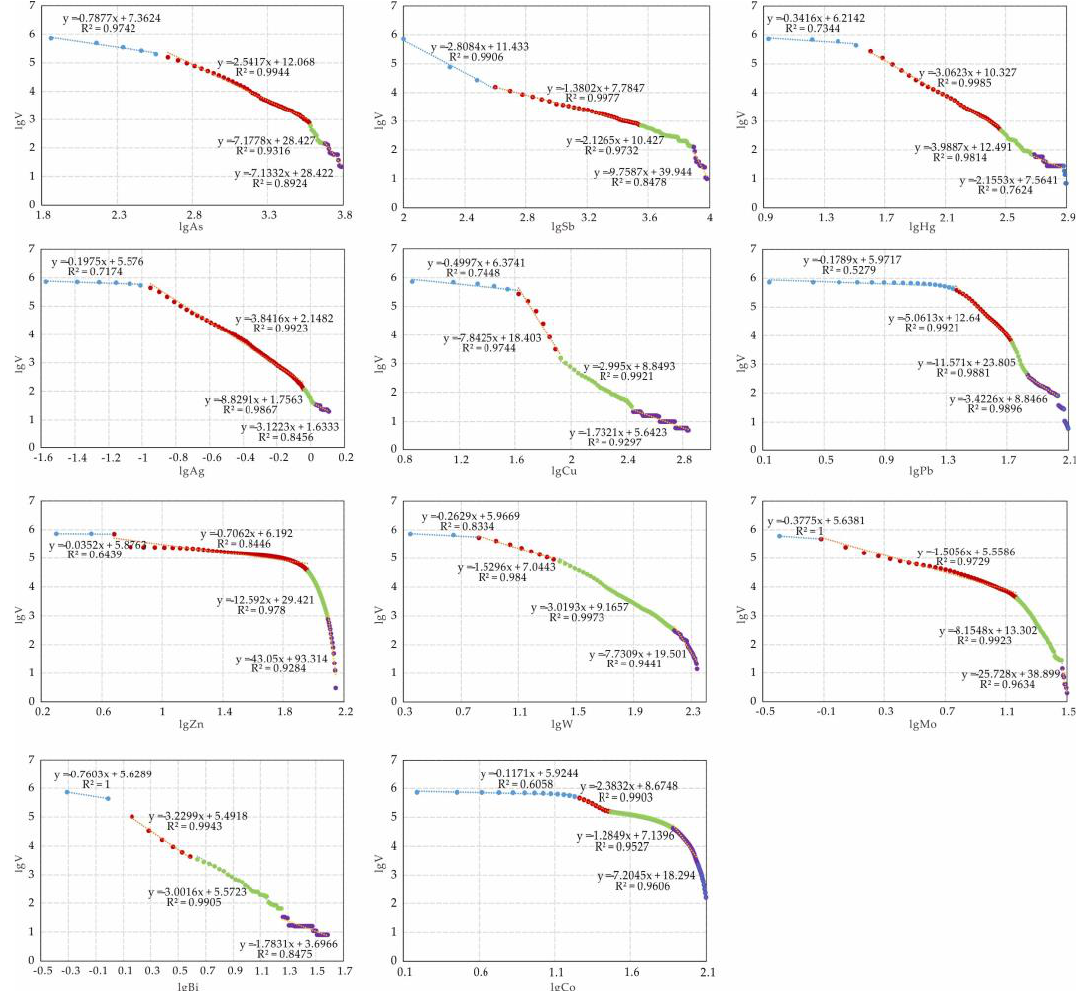
Figure 8. lg-lg graph of the 3D data volume model.